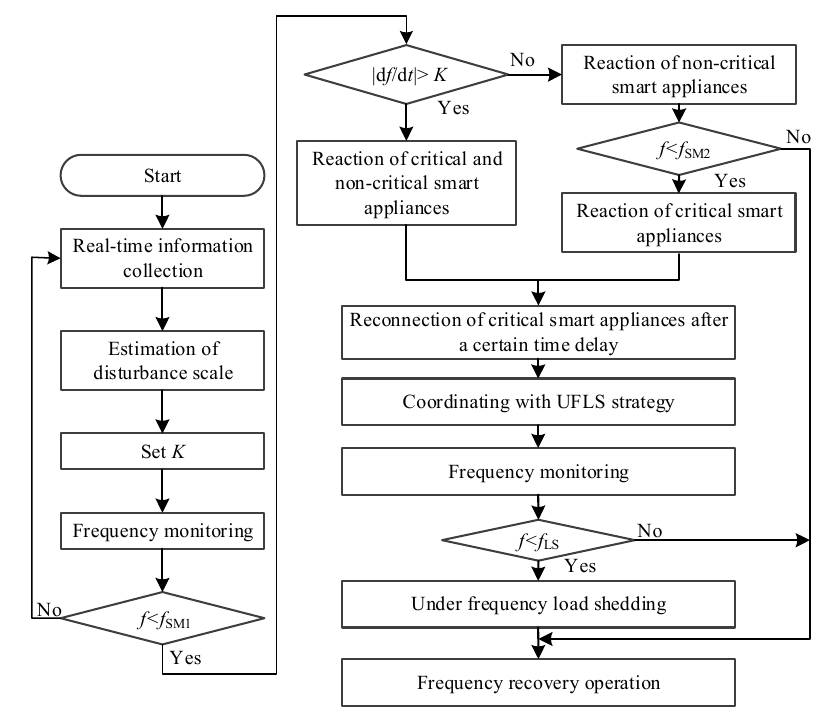
Figure 6. Control strategy of the UFLS scheme in the context of intelligent appliances.